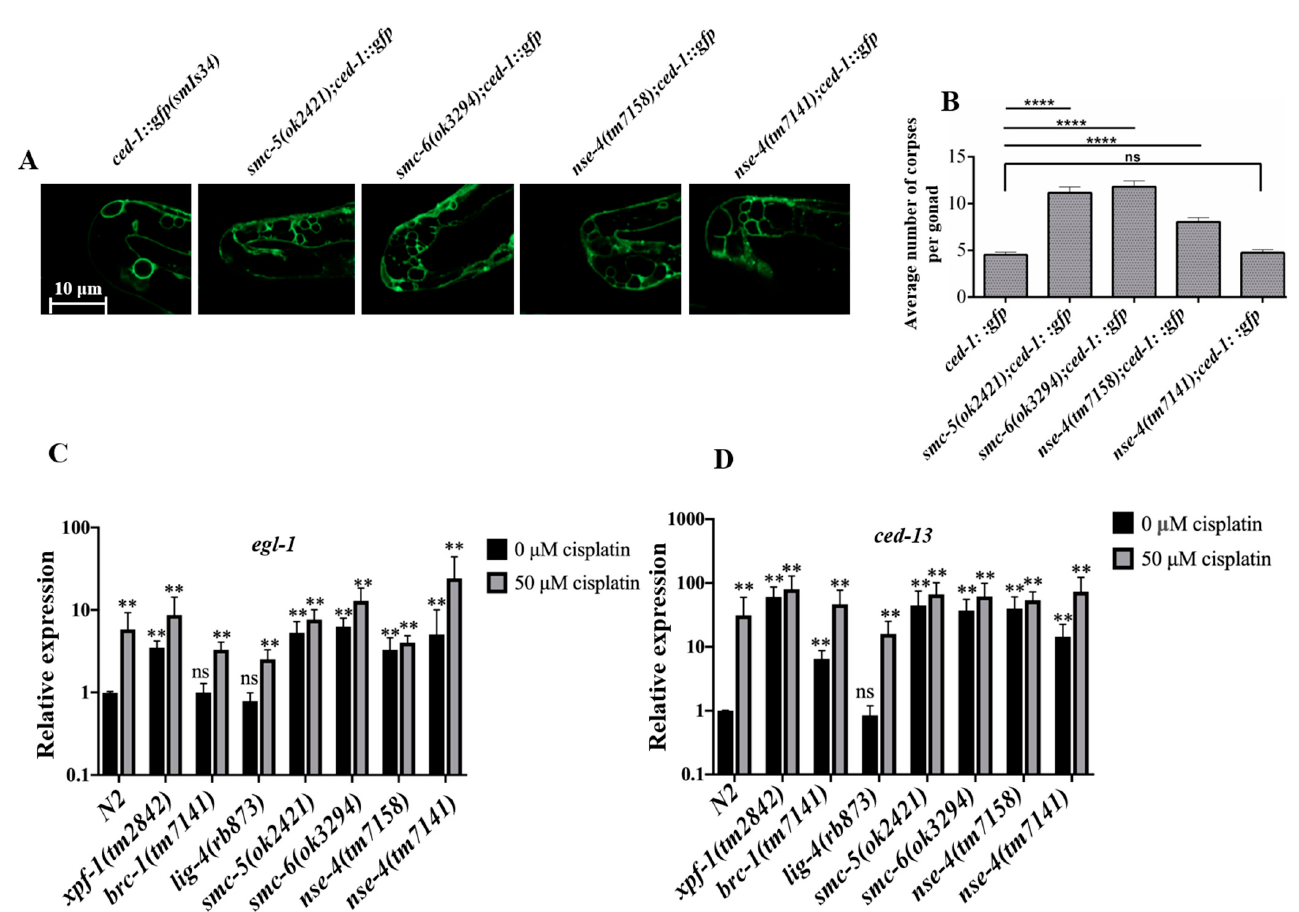
Figure 6. Mutations in nse-4 lead to increased apoptosis in the C. elegans germline. ( A ) CED-1::GFP surrounds the apoptotic cells in the gonad arm and creates a ring of GFP fluorescence around dying cells. ( B ) Quantification of apoptotic corpses. The number of apoptotic cells significantly ( **** p < 0.0001) increased in smc-5(ok2421) , smc-6(ok3294), and nse-4(tm7158) mutant background, but not significantly ( p > 0.05) in nse-4(tm7141) background when compared to control (One-way ANOVA with Tukey’s multiple comparisons test, number of gonad arms scored for each strain, n = 50, ns = not significant). Images were captured using Zeiss confocal microscope LSM 800 with Airyscan at 63× objective with oil immersion (scale bar = 10 μ m). Oocytes were scored using Leica DM6 B at 100× objective with oil immersion. ( C ) egl-1 in the wild-type and mutant genotypes as measured by quantitative RT-PCR, and ( D ) relative mRNA abundance for ced-13 . Xpf-1(tm2842) , brc-1(tm1145) , and lig-4(rb873) were used as control strains representing HR, inter-sister, and NHEJ pathways, respectively. Black and grey columns represent the relative expression levels (Means ± S. E. M) in different strains at 0 μ M and 50 μ M cisplatin doses, respectively, compared to wild-type at 0 μ M cisplatin dose (unpaired two-tailed Student’s t -test, ** p ≤ 0.01 and ns— p > 0.05). The experiment was repeated twice, and all strains were independently analyzed in triplicate in each experiment.